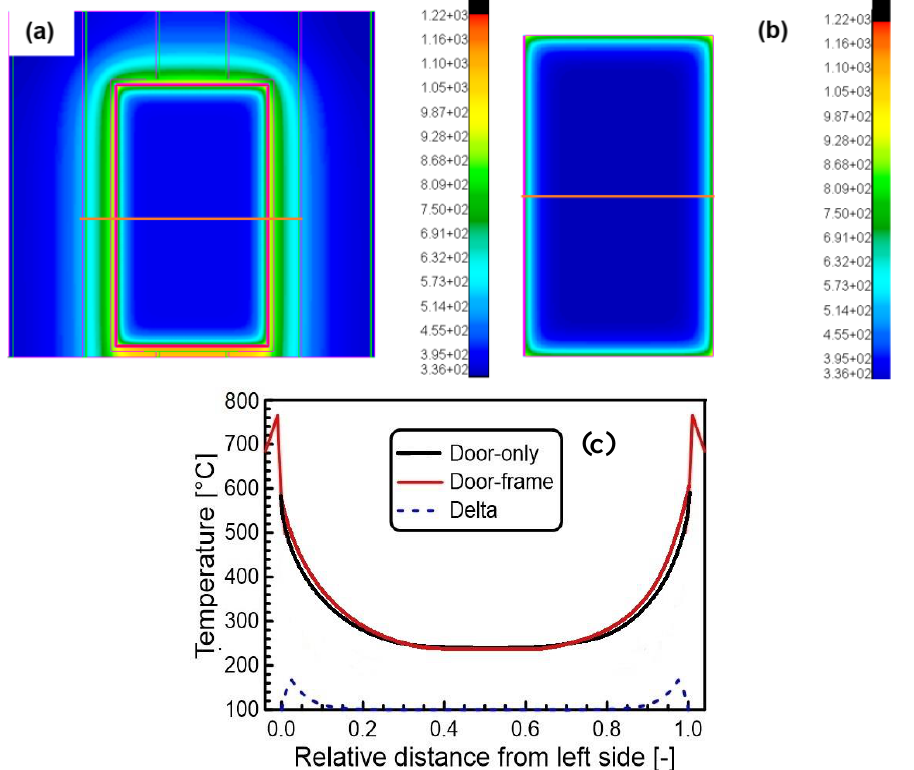
Figure 3. Temperature distribution (K) on the door fire-unexposed side calculated at the final stage of the fire test (60 min): ( a ) door-frame and ( b ) door-only model; ( c ) transversal temperature calculated along the horizontal lines in ( a ) and ( b ) (0 and 1 represent the door edges). Delta: temperature difference between the two profiles. Analysis performed using unsteady finite element method (FEM) analysis (compare next section).